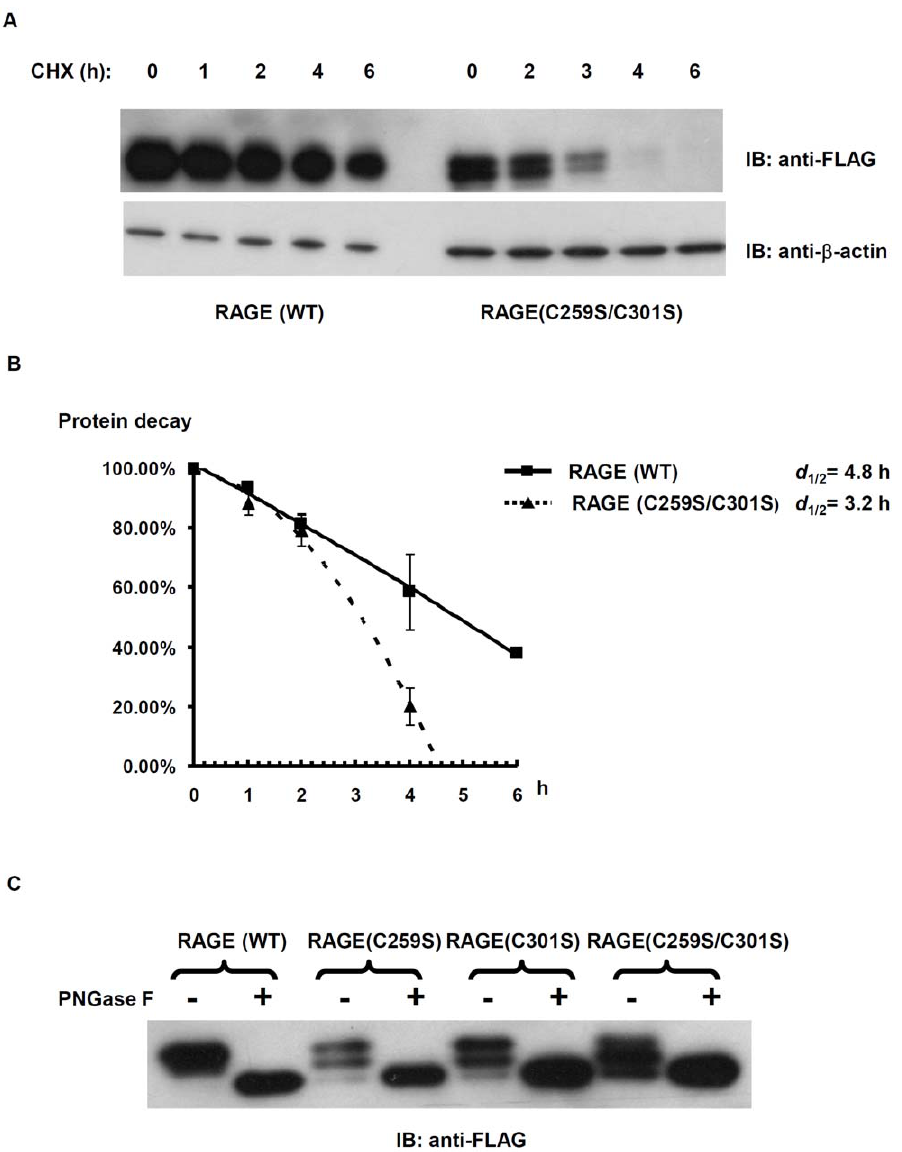
Figure 8. RAGE(C259S/C301S) is unstable and deglycosylated. ( A ) Cyclohaximide chase and IB to compare the protein decay of RAGE(WT) and RAGE(C259S/C301S) in the cells. For FLAG-RAGE transfected cells, 5 m g of lysates were used; whereas for FLAG-RAGE(C259S/C301S) transfceted cells, 10 m g of lysates were used due to the lower expression. After IB with anti-FLAG antibodies, the blot was striped, and reprobed with anti- b -actin antibodies as a loading control. CHX: cyclohaximide. ( B ) Intracellular decay rate of RAGE and RAGE(C259S/C301S) calculated from two CHX chase experiments. The blot intensity was measured with a Kodak Gel Logic 2200 Imaging System and processed with molecular imaging software. The starting point was used as 100% and blot intensity from each time point was calculated relative to the 0 time point. The intensity value of each point was expressed as mean 6 SEM, and d 1/2 was calculated when 50% of the protein I decayed. C , RAGE cysteine-to-serine mutants are deglycosylated. Cell lysates from FLAG-tagged RAGE and RAGE cysteine-to-serine mutants were treated with PNGase F, as described, and resolved on a SDS